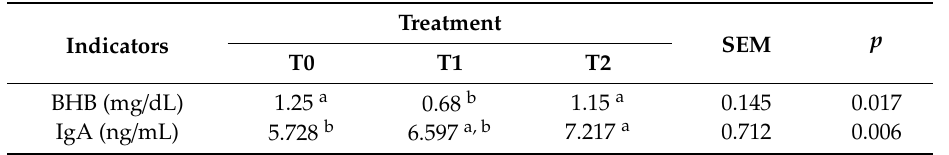
Table 5. E ff ect of oral administration with Lactobacillus plantarum CAM6 on serum d - β -hydrobutyrate and immunoglobulin A concentration in weaned